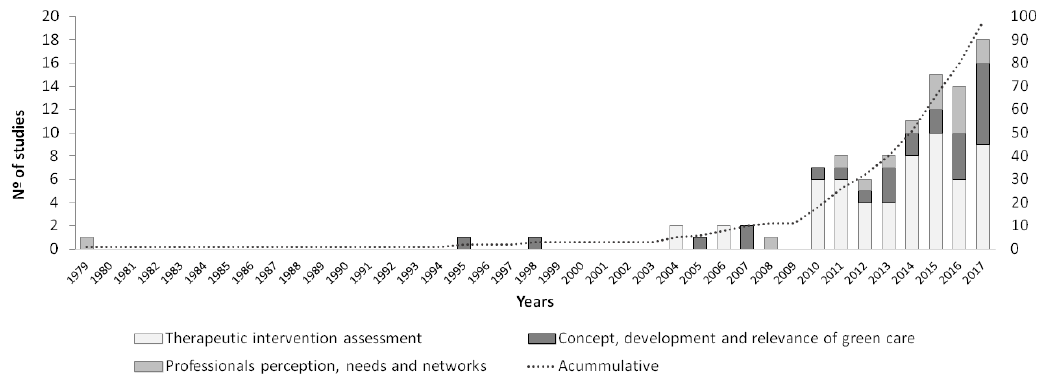
Figure 3. Temporal trends in published research by the study purpose.